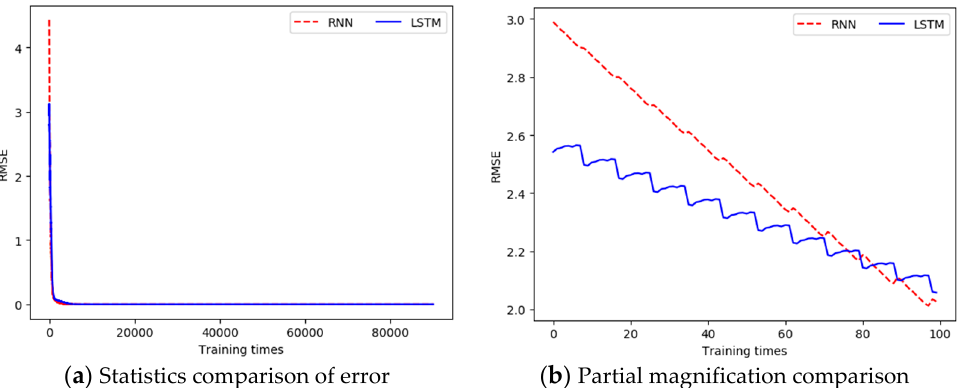
Figure 8. Comparison of the error between the pH output value and the real value in each training.